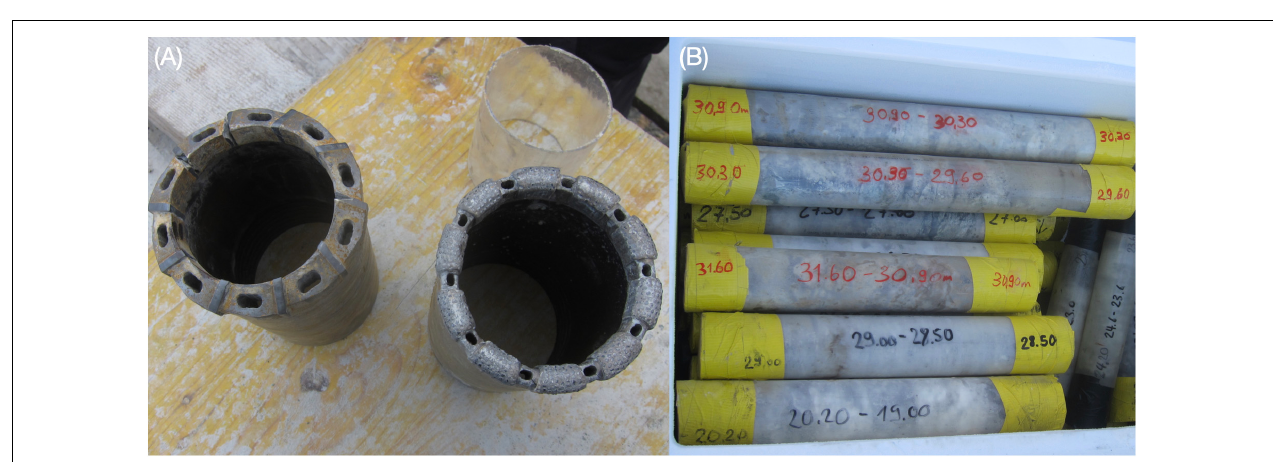
FIGURE 4 | Drilling platforms: in steep bedrock at Gemsstock in 2006 ( A , photo: A. Bauder) and at Aiguille du Midi in 2008 ( B , photo: J. Noetzli). A walking excavator with drill head was used on Murtèl-Corvatsch rock glacier in 2015 ( C , photo: J. Noetzli).